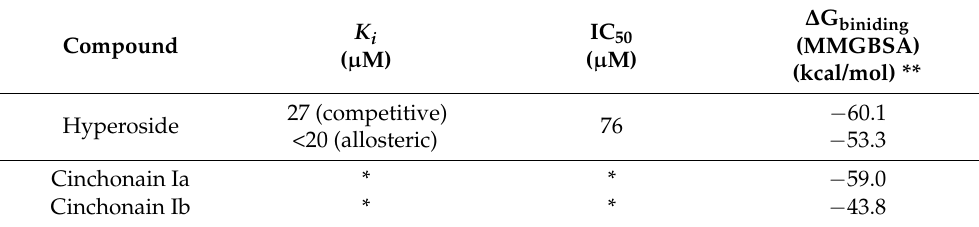
Table 2. M pro inhibition values exhibited in in vitro assays by the compounds selected for experimen- tal activity determinations. Compounds are ordered according to their best Free Binding Energies Computed for the complete Molecular Dynamics